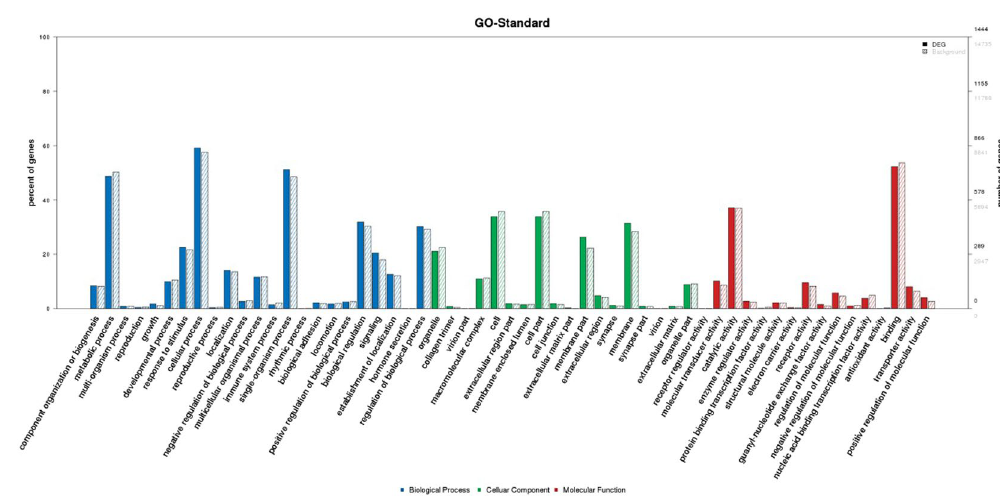
Figure 3. Functions of differentially methylated genes after exposure to fipronil ( + , − ) were annotated and classified using the Gene Ontology